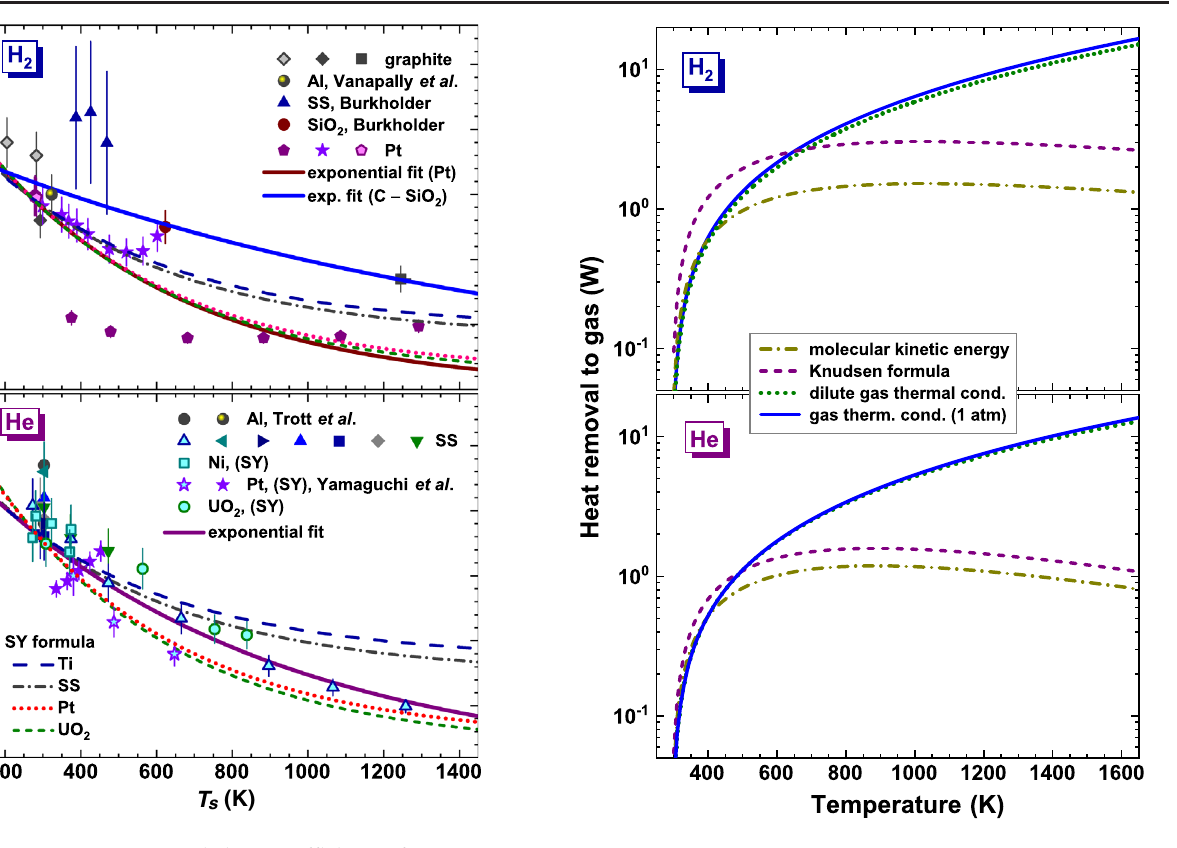
FIG. 4. Data on accommodation coefficients for H 2 on FIG. 5. Heating powers removed from the UO 2 target and Ti graphite [36 – 38], Al [39], stainless steel (SS) [40], SiO 2 [40], backing ( r t ¼ 0 . 5 cm) by rarefied H 2 and He gases as functions and Pt [41 – 43] (upper panel), and those for He on Al [44], SS of surface temperature are shown in the upper panel and bottom [35,44 – 46], Ni [35], Pt [35,47], and UO 2 [35] (bottom panel) are panel, respectively. Estimates dealing with the gas molecular shown by different symbols (He data used in Ref. [35] are marked kinetic energy considerations, corresponding to Eq. (4) and as [SY]). Respective lines show calculations with the empirical Knudsen ’ s formula of Eq. (6), along with the thermal conduc- SY formula [35] for specified solid surfaces and the results of tivity, corresponding to Eq. (11) and the approximation [52], are exponential function fitting the data. shown by respective ffiffiffiffiffiffiffiffiffiffiffiffiffiffiffiffiffiffiffiffiffiffiffiffiffiffiffi